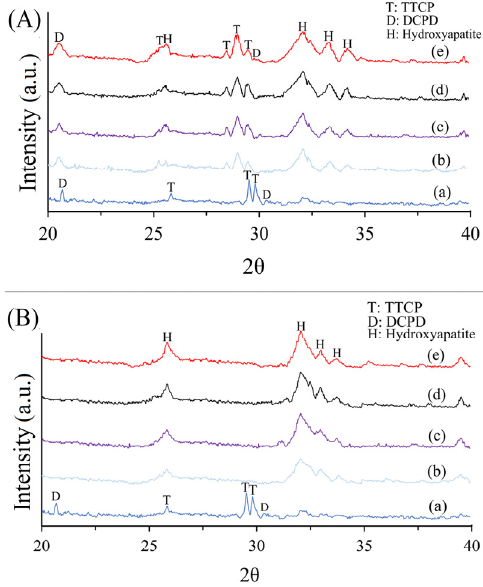
Figure 3. XRD patterns of different samples ( A ) after incubation for 24 h ( B ) after 7 days of immersion in SBF solution. (a) Cement powders, (b) CPC-0, (c) CPC-1, (d) CPC-3, and (e) CPC-5.